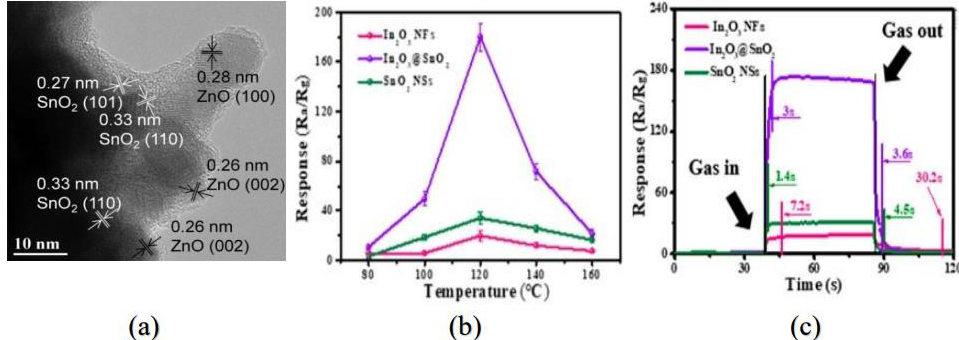
Figure 10. ( a ) High-resolution TEM image [69]; ( b ) response toward 100 ppm of HCHO at operation temperature ranging from 80 to 160 °C; ( c ) response curves [70].